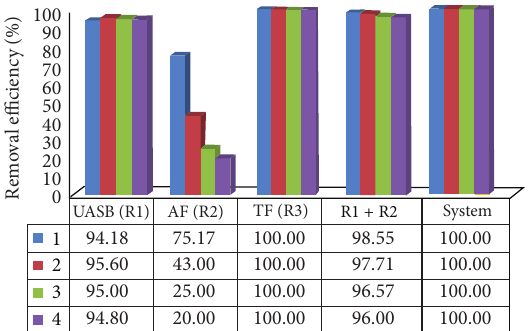
Figure 8: Average values of the removal efficiencies of Ascari ssuum eggs in the UASB reactors and anaerobic filter (R1 and R2) and R1 + R2 and system (R1 + R2 + R3 + Dec.) of treatment system II in assays 1, 2, 3, and 4.